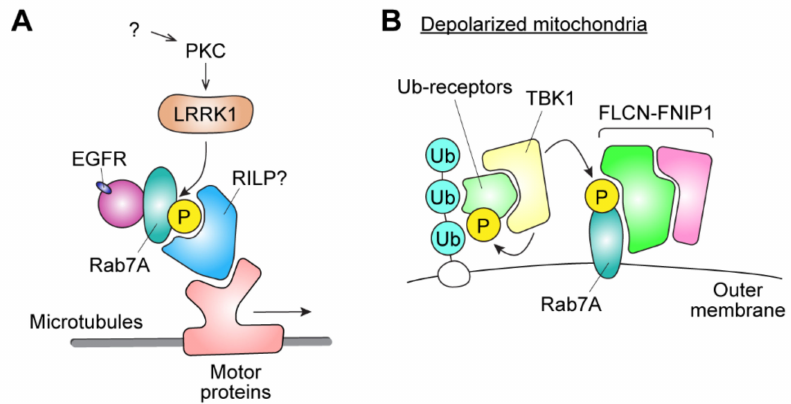
Figure 4. Proposed biological roles of Rab7A phosphorylation. ( A ) Phosphorylation of Rab7A by LRRK1 increases its affinity to RILP or other effectors, thereby facilitating the transport of EGFR- containing vesicles. Phosphorylation of Rab7A by LRRK1 is activated by PKC. ( B ) On the outer membrane of depolarized mitochondria, ubiquitylation of outer membrane proteins by